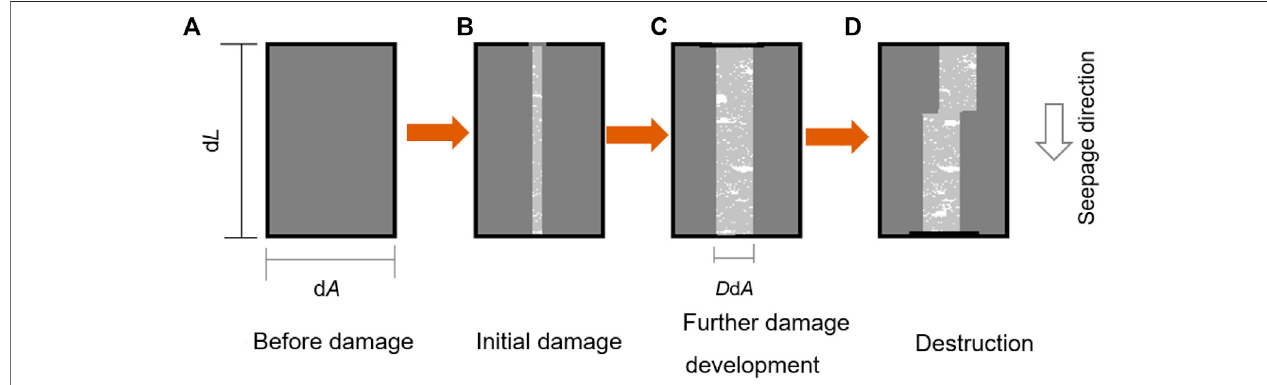
FIGURE 11 | Damage evolution process of representative voxel. (A) Before damage. (B) Initial damage. (C) Further damage development. (D) Destruction.